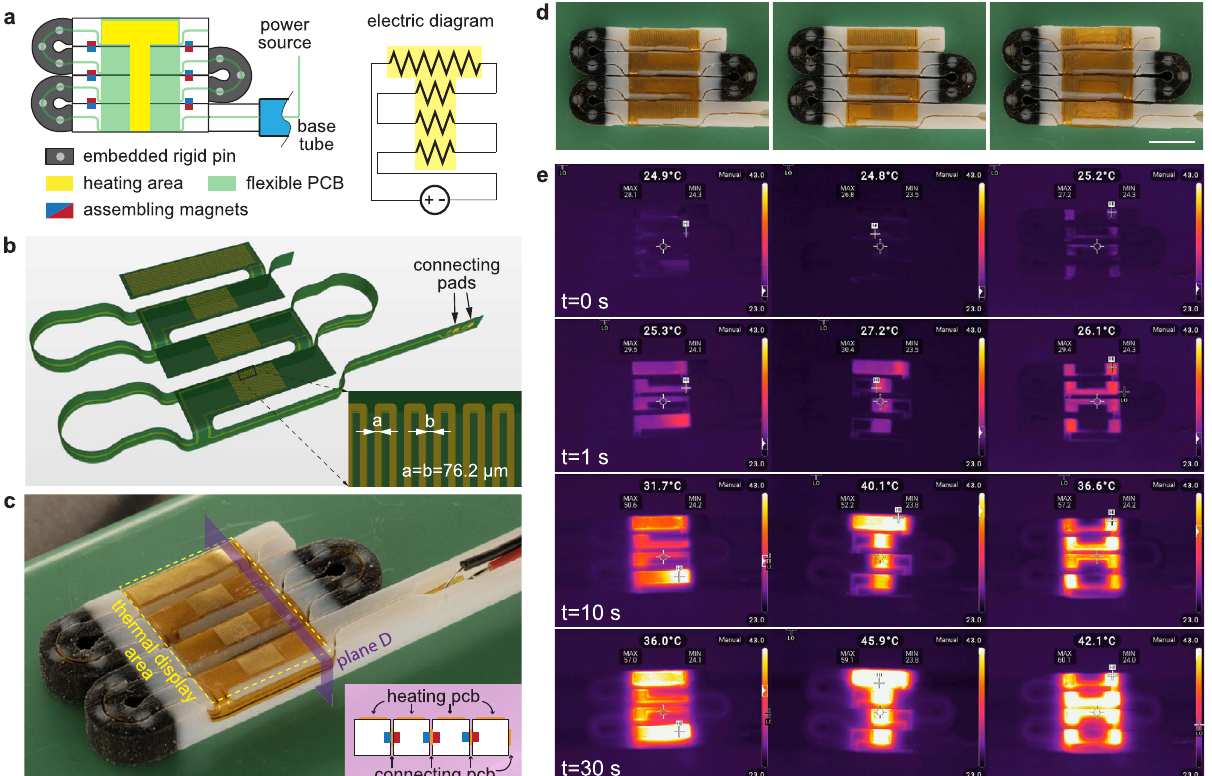
Fig. 7 | Programmable heating surface through self-folding MaSoChains. a An illustration of the mechanical structure and electrical con fi gurations between heat elements on the fl exible PCB. b An illustrated bird ’ s eye view of a 3D-structured fl exiblePCBgeometryafterassembly. c Opticalimageofthesampleafterassembly with a thermal display area (marked by dashed yellow lines). A cross-section view